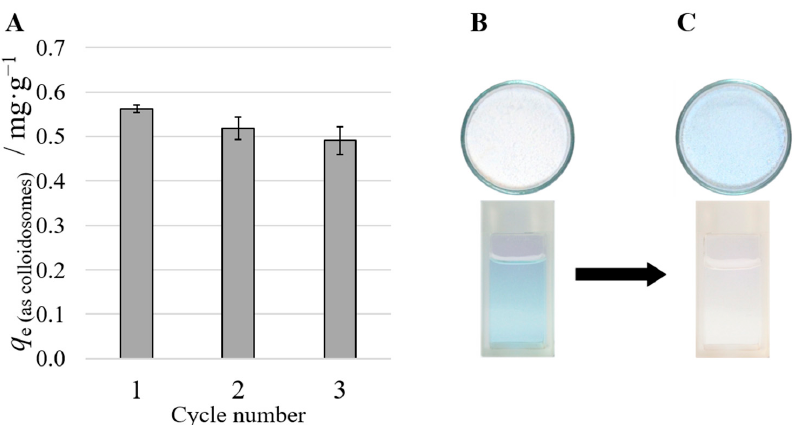
Figure 6. ( A ) Extraction performance of Cu(II) by wax colloidosomes stabilized with JNP-bPEI 3 mL after 3 consecutive extraction/recovery cycles. (B,C) Qualitative proof of the interfacial absorption/extraction of Cu(II) ions from water by floating JNP-bPEI decorated wax colloidosomes. To accurately represent the colors of the solution and the colloidosomes, they were photographed separately. ( B ) A layer of white, pristine (unwetted) colloidosomes with a mass of 6 g is floating on the surface of 10 mL of a blue 10 mM Cu(II) sulfate solution. ( C ) The sample was mechanically shaken and then left to separate overnight. After extraction of the solution with an appropriate amount of colloidosomes, the former becomes colorless while the latter appears bright blue.